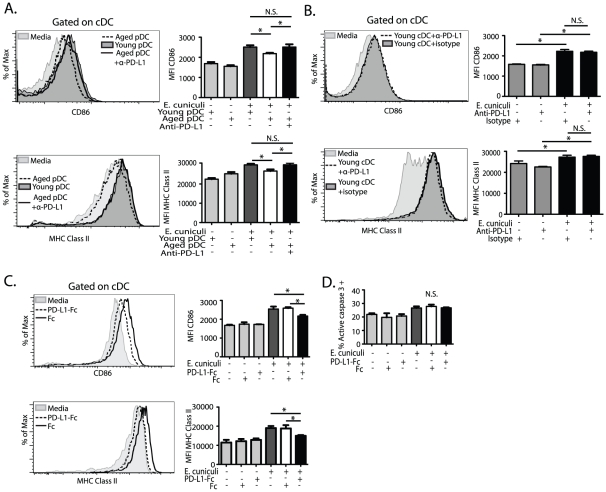
Aged pDC suppress cDC maturation via PD-L1 dependent pathway.1.25×105 sorted naïve splenic young cDC were co-cultured with 1.0×104 naïve splenic young or aged mouse pDC with anti-PD-L1 (30 µg/ml) then stimulated with irradiated E. cuniculi spores for 12 hours. (A) Representative histogram shows CD86 (top panel) and MHC Class II (bottom panel) expression on unstimulated (light gray filled) cDC or on cDC stimulated with E. cuniculi while in co-culture with aged pDC (dashed line), young pDC (dark gray filled) or aged pDC with anti-PD-L1 antibody (solid line). (B) Representative histograms show CD86 (top panel) and MHC Class II (bottom panel) expression on cDC cultured alone without (light gray filled) or with E. cuniculi stimulation in the presence of either anti-PD-L1 antibody(dashed line) or isotype control (dark gray filled). (A and B) Bar graphs show mean MFI ± SD of CD86 (top panels) and MHC Class II (bottom panels) on young cDC co-cultured with pDC (A) or culture alone (B) before (light gray bars) and after E. cuniculi stimulation with the following conditions; young pDC co-culture (dark gray bar), aged pDC co-culture (white bar) and aged pDC co-culture with anti-PD-L1 (black bars). (C) To confirm that PD-L1 can alter cDC maturation, cDC were cultured in the presence of plate bound PD-L1 Fc fusion protein (30 µg/ml), control Fc or no treatment then stimulated with E. cuniculi spores. (C) Representative histograms and bar graphs of mean ± SD MFI for CD86 (top panel) and MHC Class II (bottom panel) are shown. (D) Bar graph shows percent of cDC active caspase-3 positive ± treatments shown in C. Data presented are from 2 experiments repeated independently with quadruplicate replicates.* denotes significance with p<0.05 by 1 way ANOVA and Bonferonni's multiple comparison test.